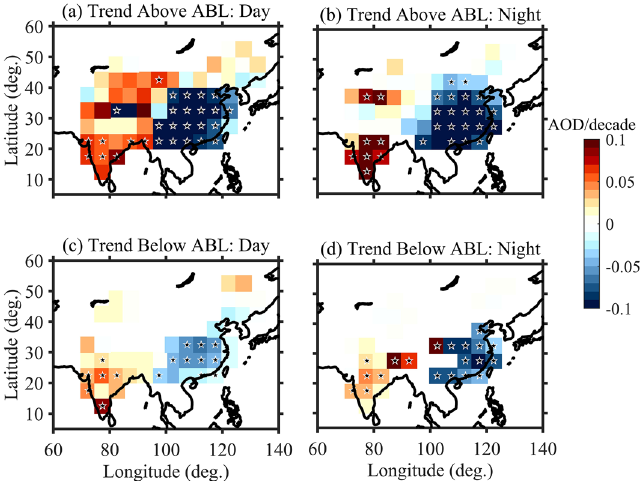
Figure 4. Trends in AOD observed in the free troposphere during ( a ) day time and ( b ) night time over south and East Asia obtained using CALIOP measurements during 2006–2018. ( c ) and ( d ) same as ( a ) and ( b ) but for within the boundary layer. Star marks show the trend that is statistically significant at 95% confidence level. The maps were created by using MATLAB software R2019b with mapping tool box (see https ://in.mathw orks.com/ produ cts/new_produ cts/relea se201 9b.html and https ://www.mathw orks.com/produ cts/mappi